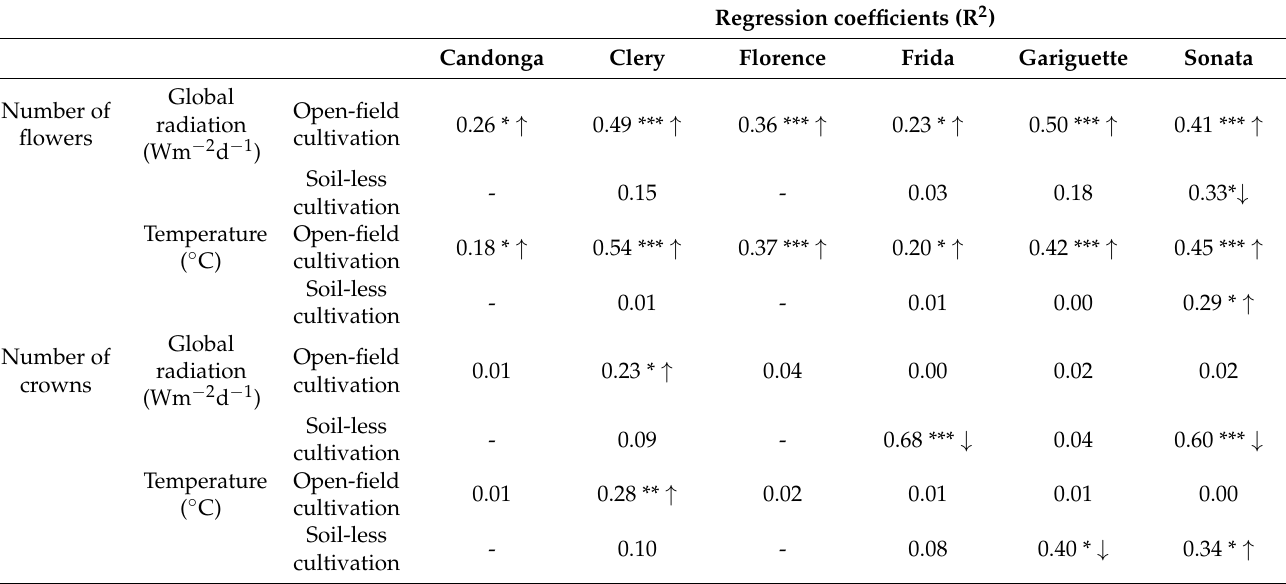
Table 6. Regression coefficients (R 2 ) for six strawberry cultivars for their number of flowers and crowns related to global radiation and temperature during the 5-week period preceding flower initiation when grown at five locations in